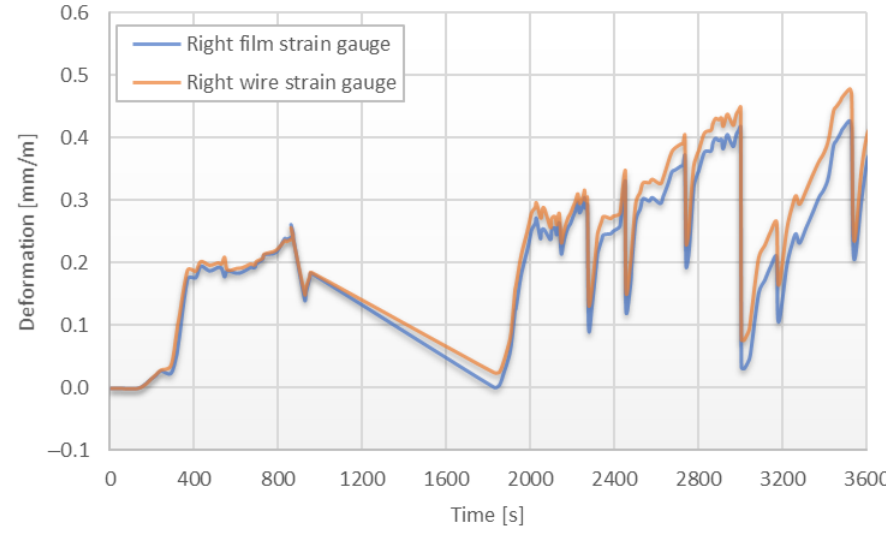
Figure 17. Results of deformation (right side).